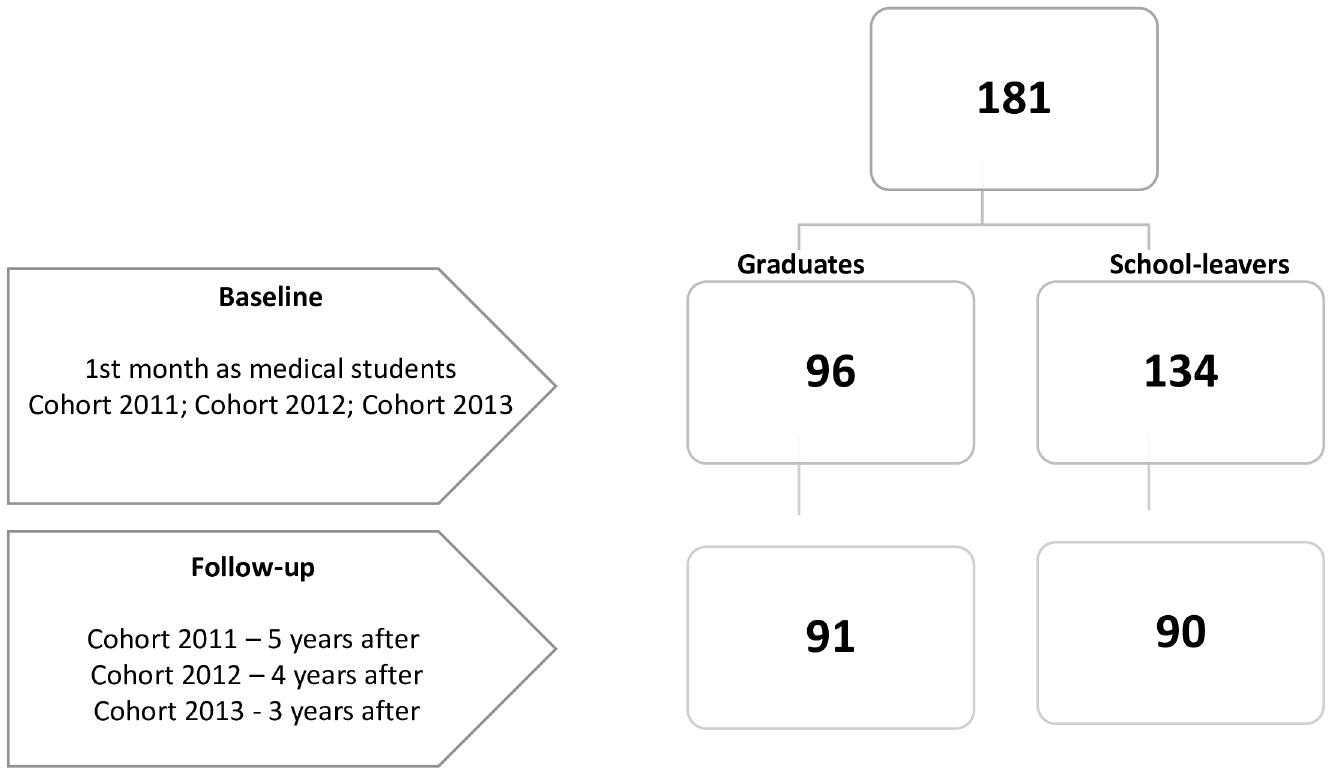
Fig 1. Flow of the